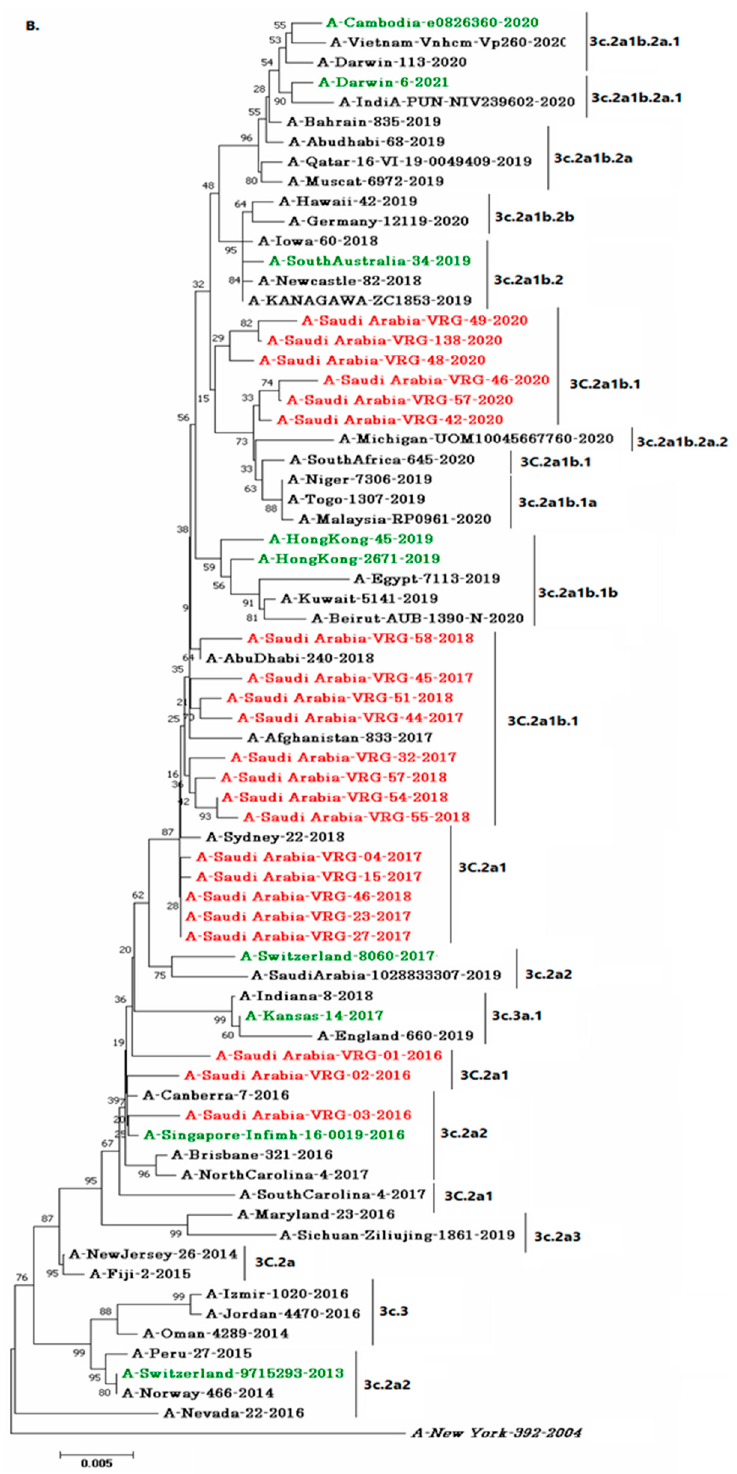
Figure 2. Phylogenetic for H3N2 strains, according to HA gene ( A ), NA gene ( B ). The Saudi H3N2 strains are indicated with red ink whereas the vaccine strain is indicated using green ink. The reference strains are denoted by black and italics.